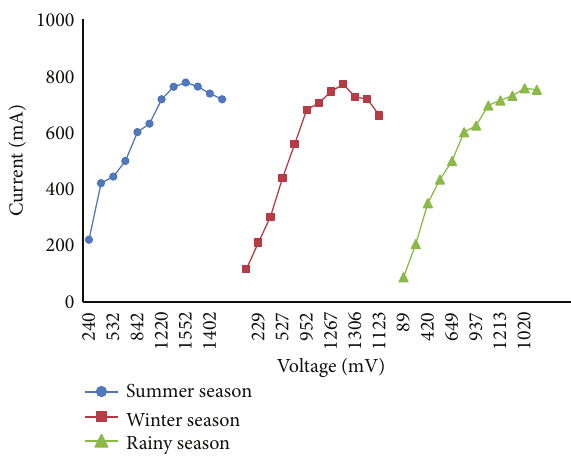
Figure 8: Comparison of voltage versus current in the duration of 8.00–10.00 am in summer, winter, and rainy season.